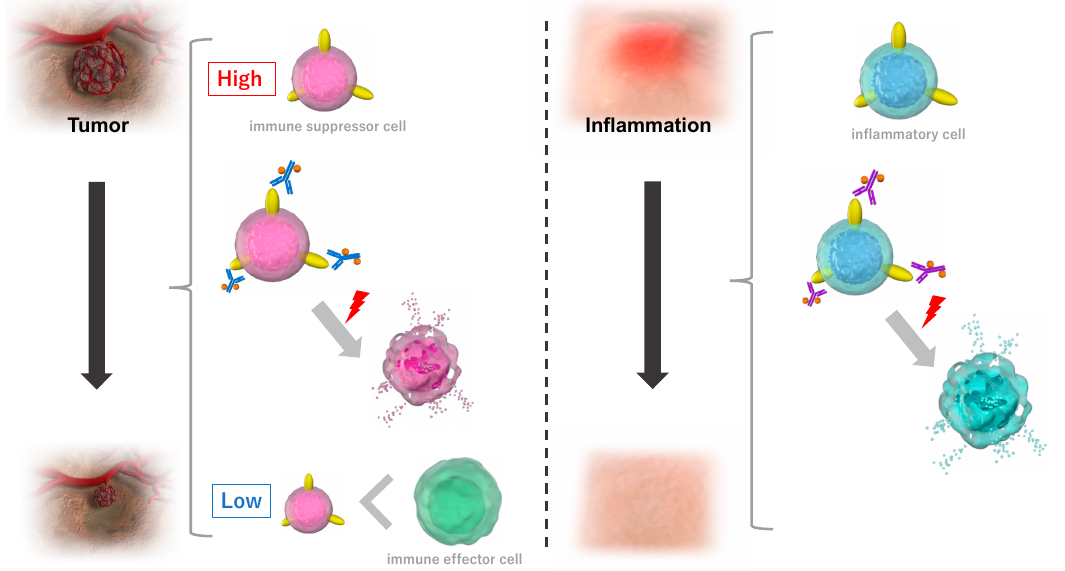
Figure 2. Applications of NIR-PIT as a technique that can target and locally eliminate specific immune cell subsets. Schematics of NIR-PIT as it activates local immune responses and induces anti-tumor responses by targeting immune suppressor cells in the tumor microenvironment ( left ), and targets inflammatory immune cells to reduce tissue damage ( right ).